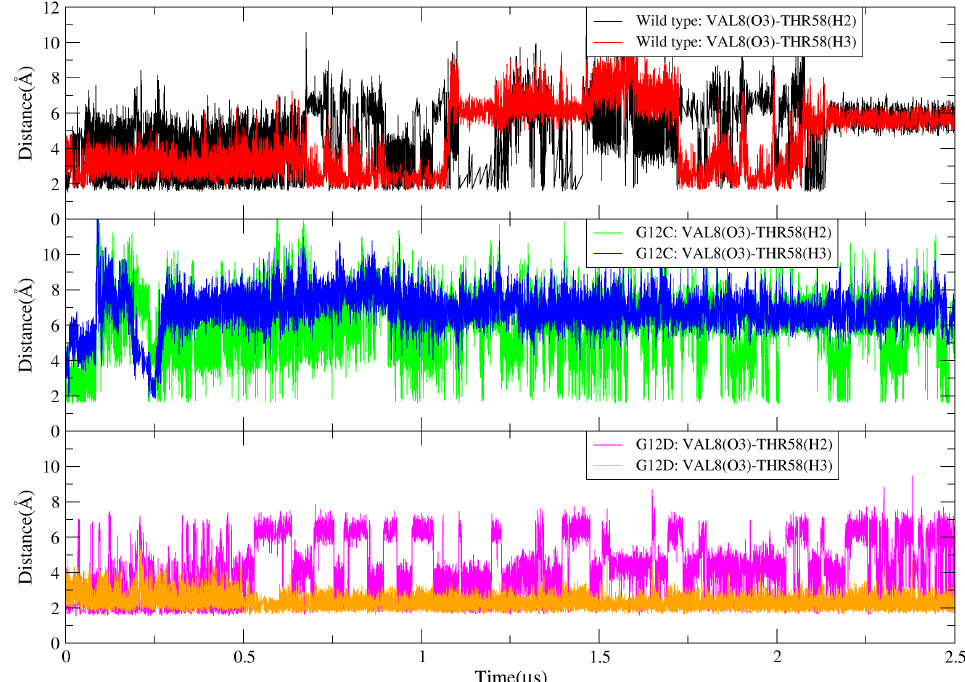
Figure A6. Atom-atom distance between oxygen atom (O3) of residue VAL8 and hydrogen atom (H2 and H3 of THR58) of KRAS